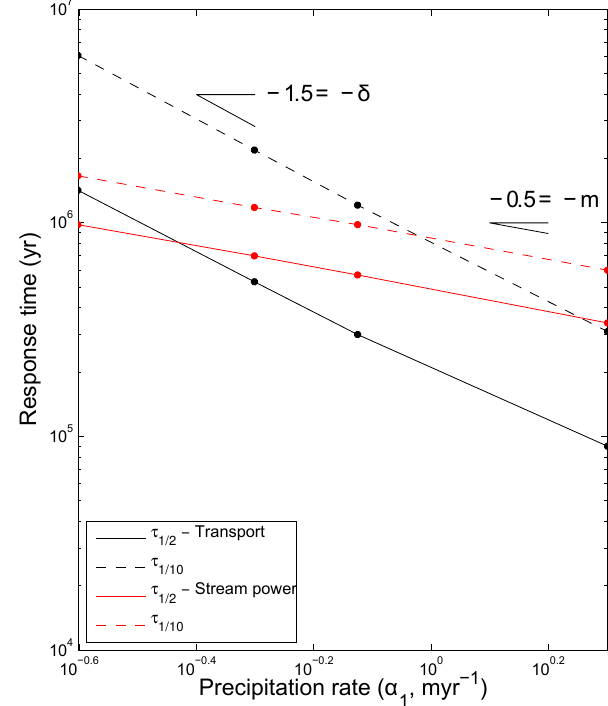
Figure 9. (a) Response of the transport model to a change in precipitation rate. Equation (6) is solved for δ = 1 . 5 and c = 1 × 10 − 4 (m 2 yr − 1 ) 1 − δ . The precipitation rate is initially α 0 = 1myr − 1 and changes to α 1 = 0 . 25, 0.5, 0.75, or 2myr − 1 after 10Myr. (b) Response of the stream power model to a change in precipitation rate. Equation (6) is solved for m = 0 . 5 and k = 1 × 10 − 5 m − 1 (m 2 yr − 1 ) 1 − m . The precipitation rate is initially α 0 = 1myr − 1 and changes to α 1 = 0 . 25, 0.5, 0.75, or 2myr − 1 after 10Myr.